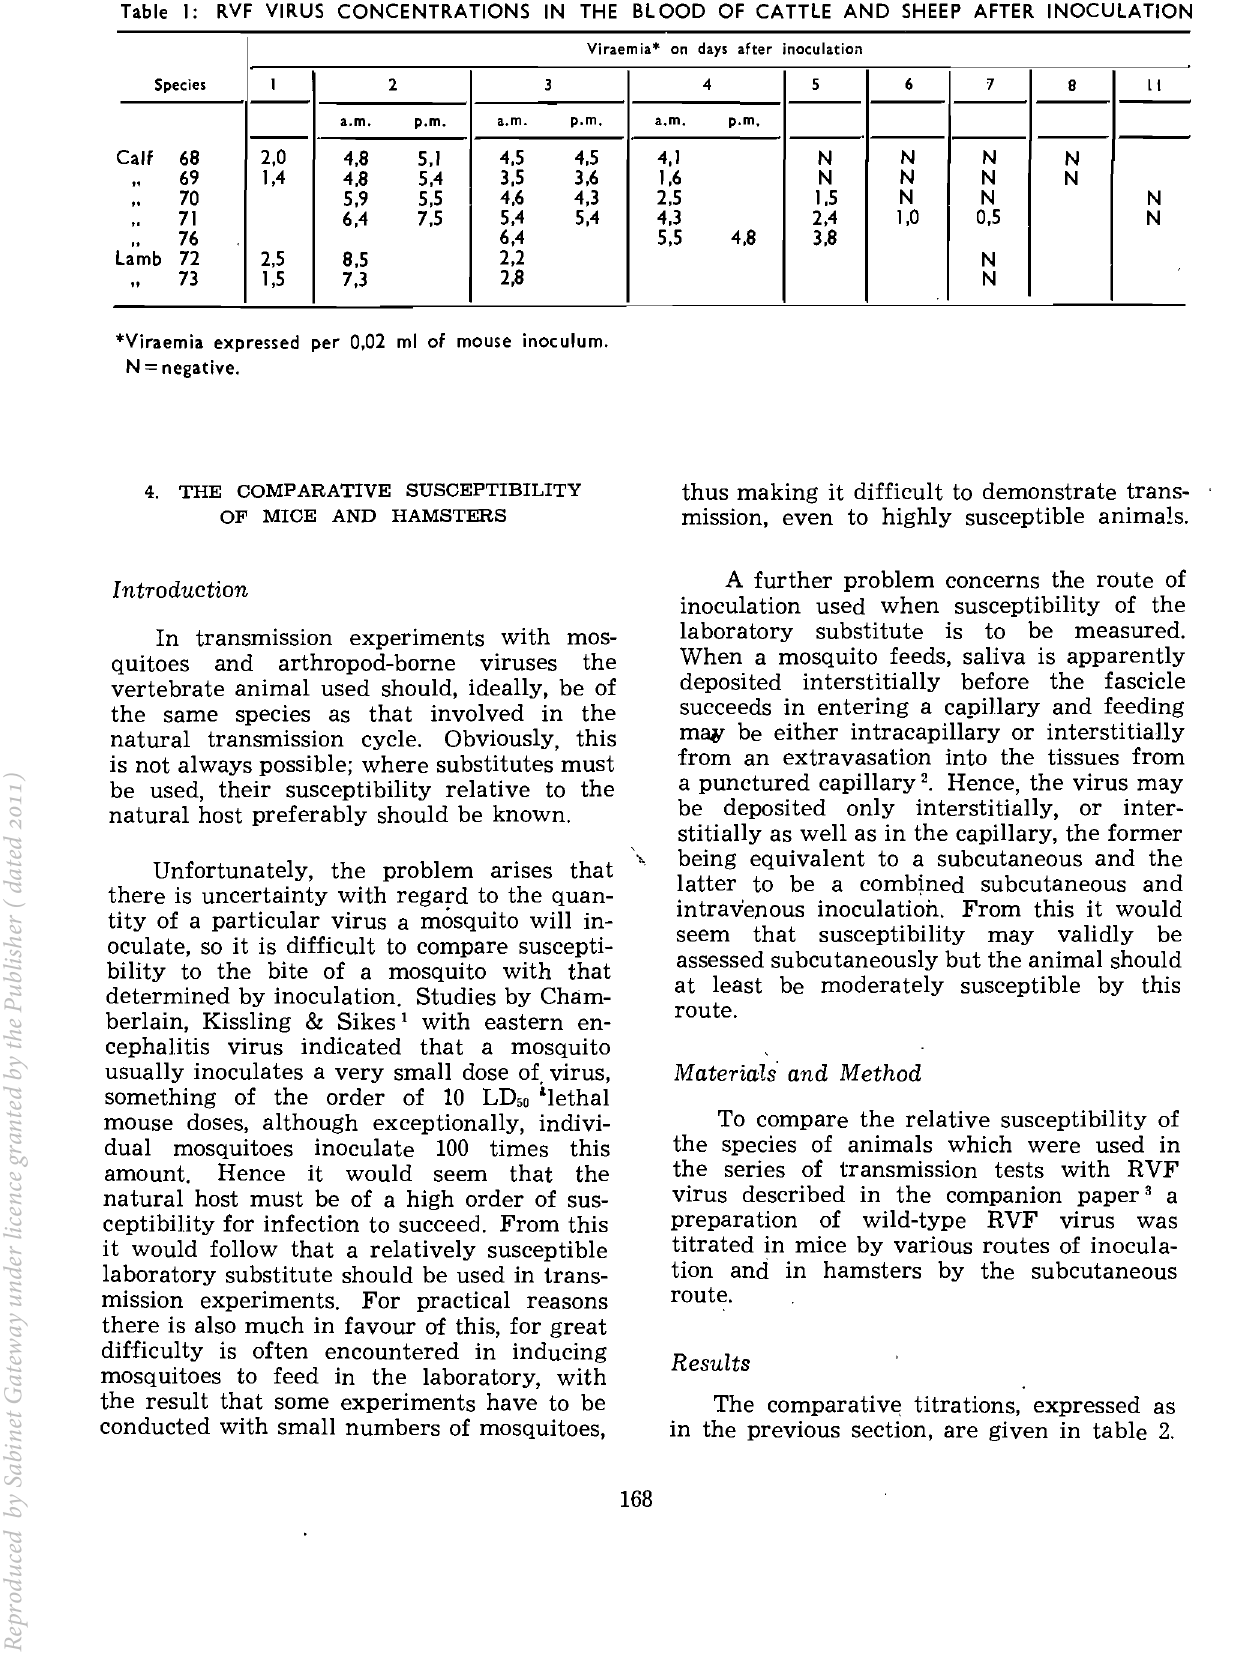
Table I: RVF VIRUS CONCENTRATIONS IN THE BLOOD OF CATTLE AND SHEEP AFTER INOCULATION